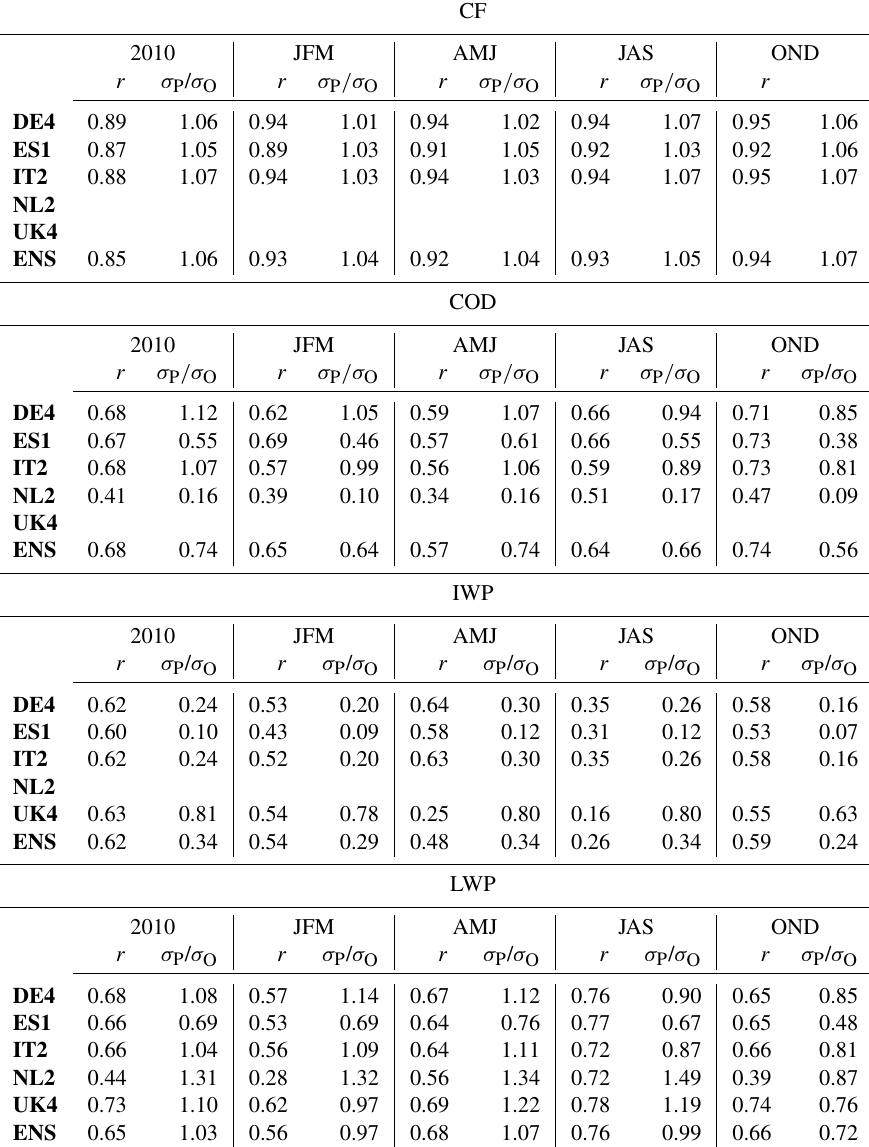
Table 3. Spatial correlation and standard deviation ratio values for CF, COD, IWP, and LWP over the following periods: 2010, JFM, AMJ, JAS, OND. r : correlation coefficient; σ P /σ O : ratio between the standard deviation of the models ( σ P ) and the observations ( σ O